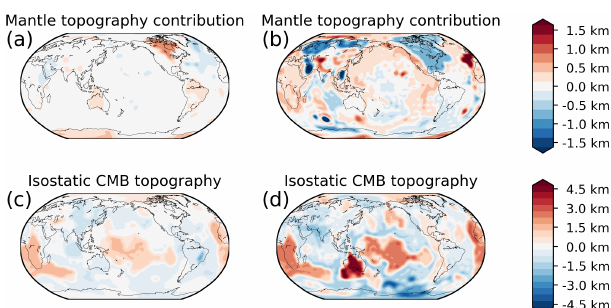
Figure 10. Isostatic contributions to boundary deformations from inverted density model. To facilitate comparison with the dynamic topography in Fig. 11 the results have been filtered to spherical har- monic degree 30. (a) Contribution of upper 300km to surface to- pography for the inversion results based on the isostatic residual. (b) The same for the results based on the crustal residual. (c) Contri- bution of the lower 800km of the mantle to topography at the core– mantle boundary based on the isostatic residual inversion. Positive values indicate a depression of the CMB. (d) The same for the crustal residual